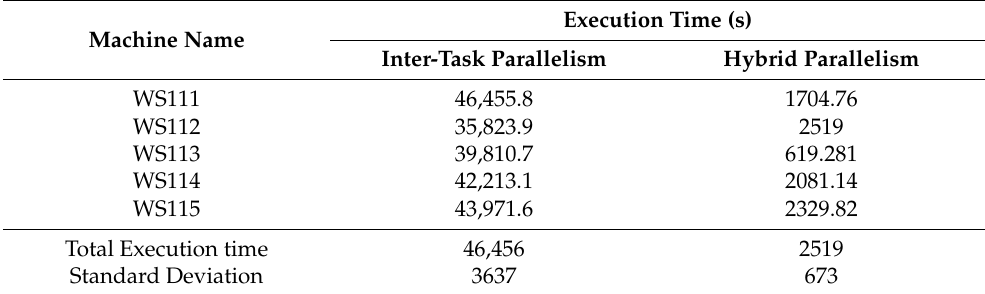
Table 2. Execution time of individual machines for one-to-many comparison using inter-task paral- lelism and hybrid parallelism.